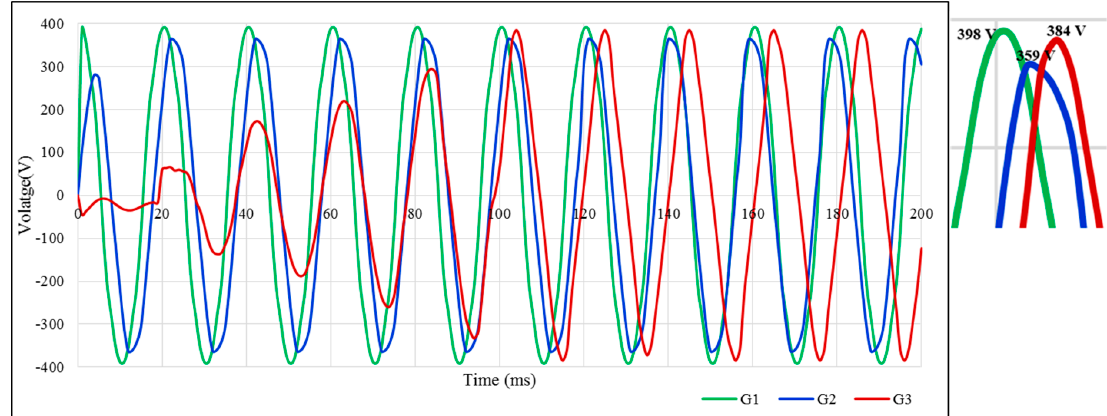
Figure 7. No-load voltage of G1, G2, and G3.